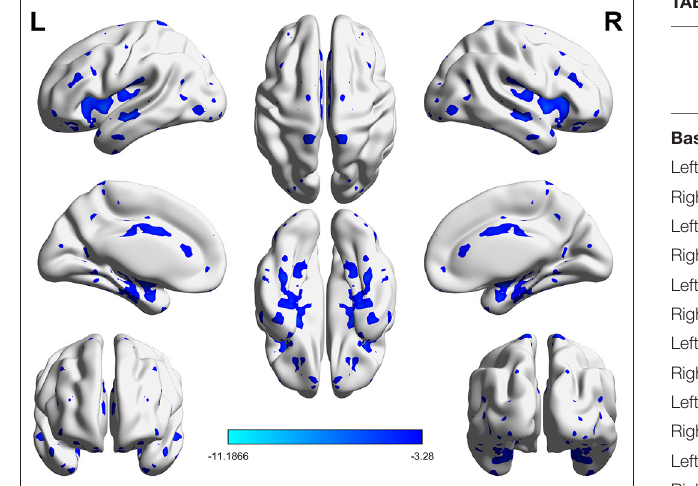
TABLE 2 | Significantly altered VMHC across the three